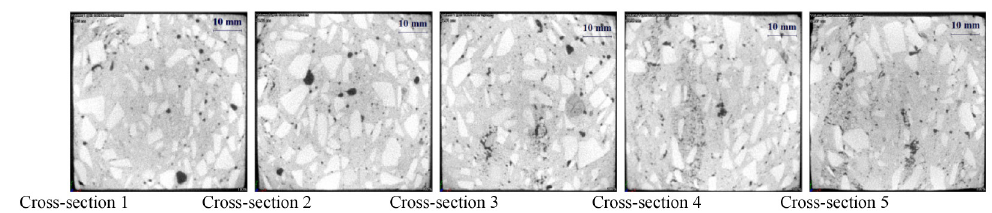
Fig. 10. CT images of each cross-section in DR2-1 before freeze-thaw cycles were